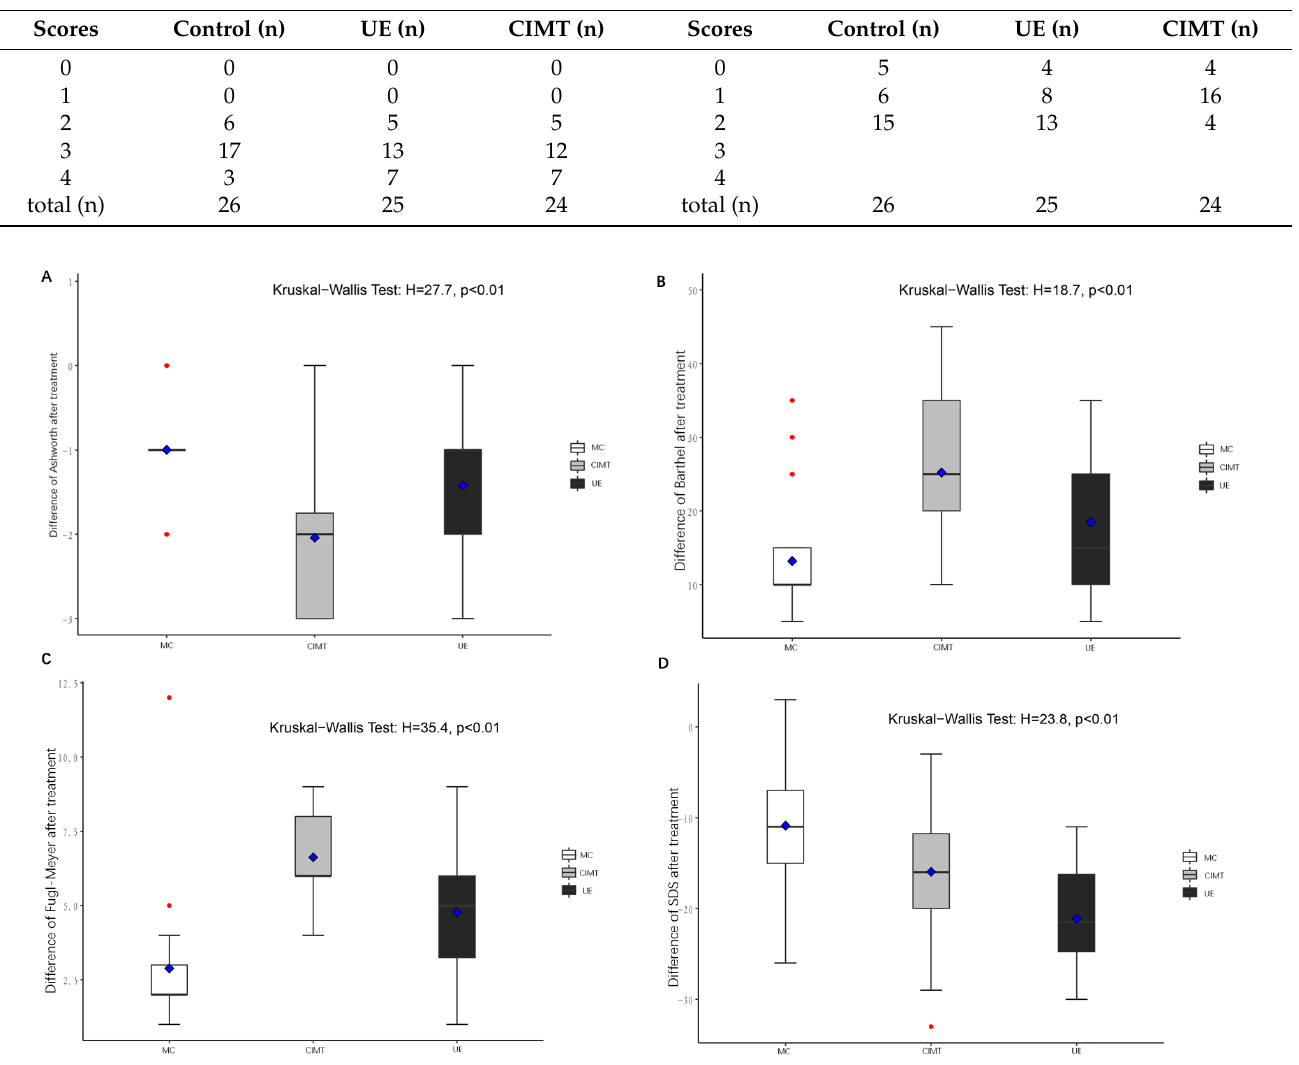
Figure 2. CIMT was more effective than UE in improving limb function in stroke patients. ( A ) change of Ashworth score before and after the treatment in each group; ( B ) change of Barthel index before and after the treatment in each group; ( C ) change of Fugl–Meyer score before and after the treatment in each group; ( D ) change of SDS before and after the treatment in each group. Significance was calculated with the Kruskal–Wallis test. MC: model control; CIMT: constraint-induced movement therapy; UE: unconstraint exercise. Table 5. The scores of FMA-UE, Barthel, and SDS before and after the interventions. FMA-UE Barthel SDS